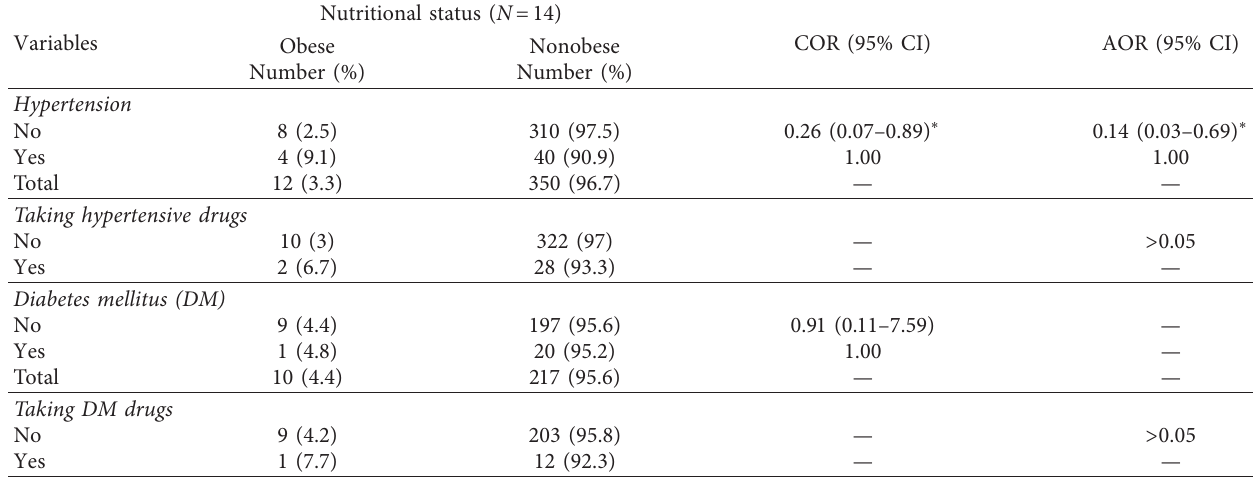
Table 4: Prevalence of hypertension and diabetes mellitus in adults of Addis Ababa who have had their blood sugar level and blood pressure measured by obesity.